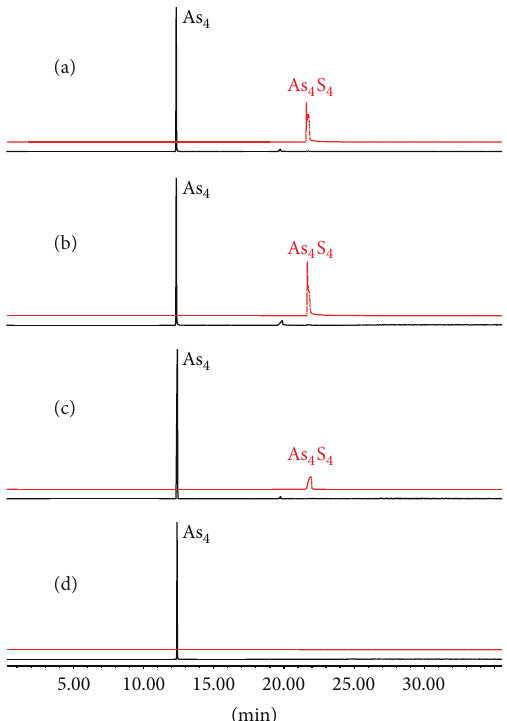
Figure 8: Ion chromatograms of the 𝑚/𝑧 300 and 𝑚/𝑧 427.6 fragment ions of Sample Y (a) and (b), Sample G (c) and (d).